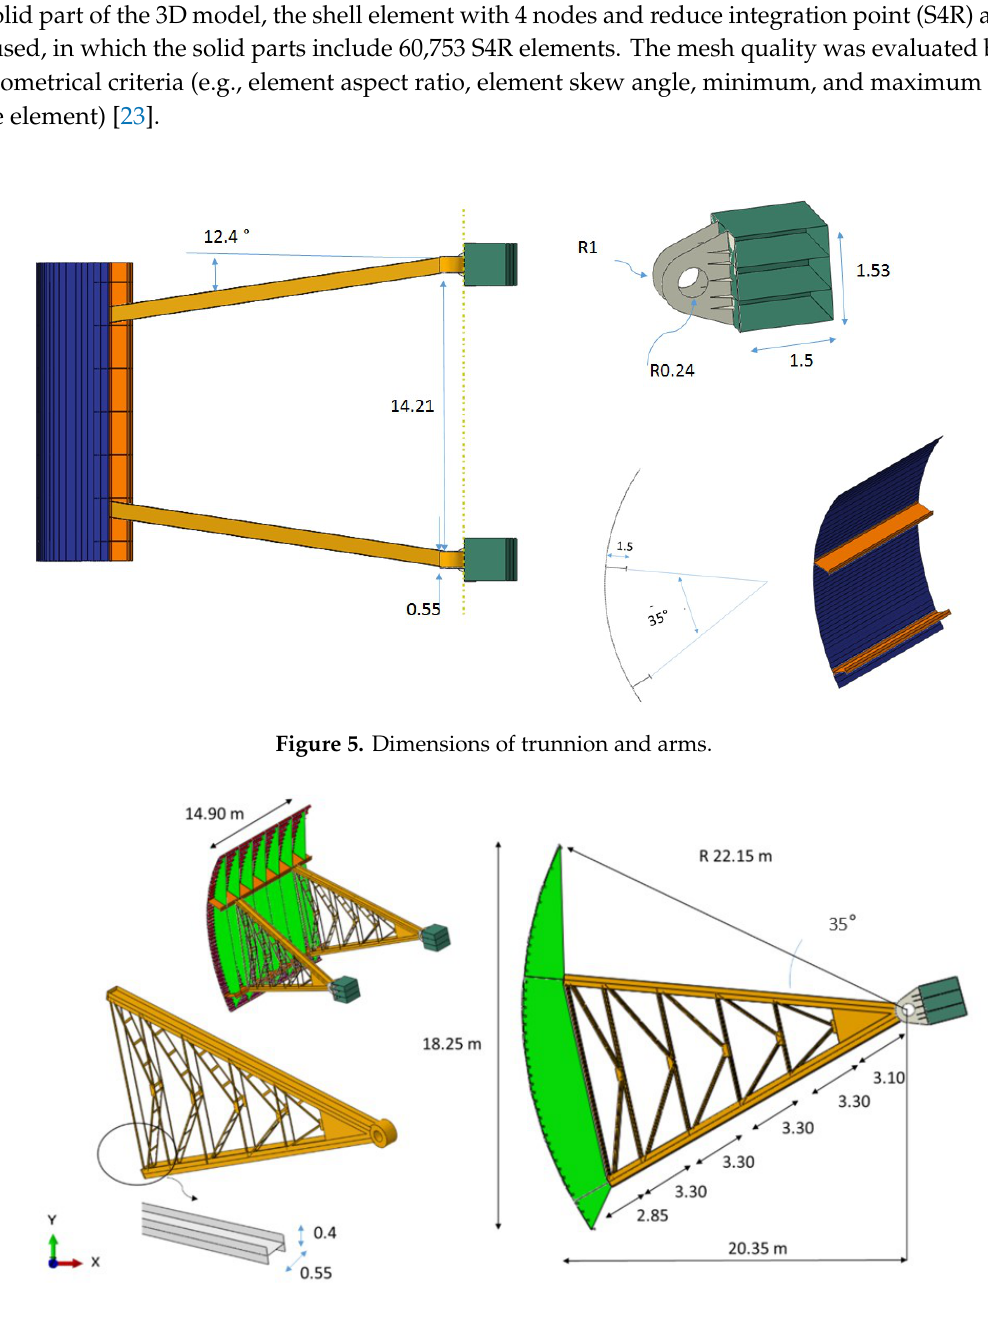
Figure 6. Dimensions of skin plate and